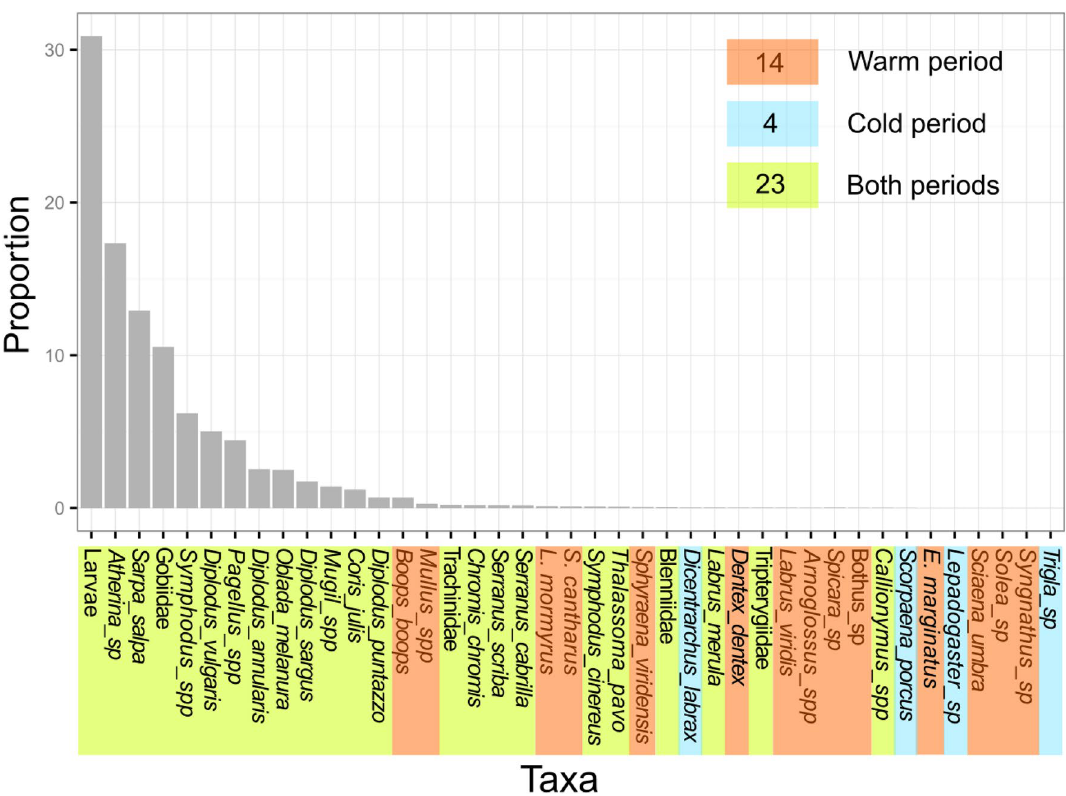
Figure 3. Proportion of each observed taxa in the total abundance of juvenile fishes recorded in all samples and habitats combined; E. = Epinephelus , L. = Lithognathus, S. = Spondyliosoma . Period(s) of observation of each taxa and total number of taxa observed per period are indicated with colored boxes.